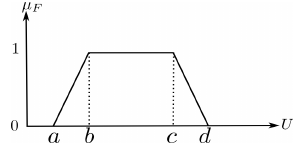
Fig. 1. Trapezoidal membership function